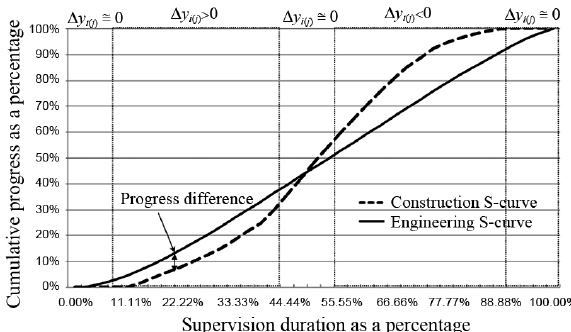
Fig. 3. Example of the engineering and construction S-curves for project